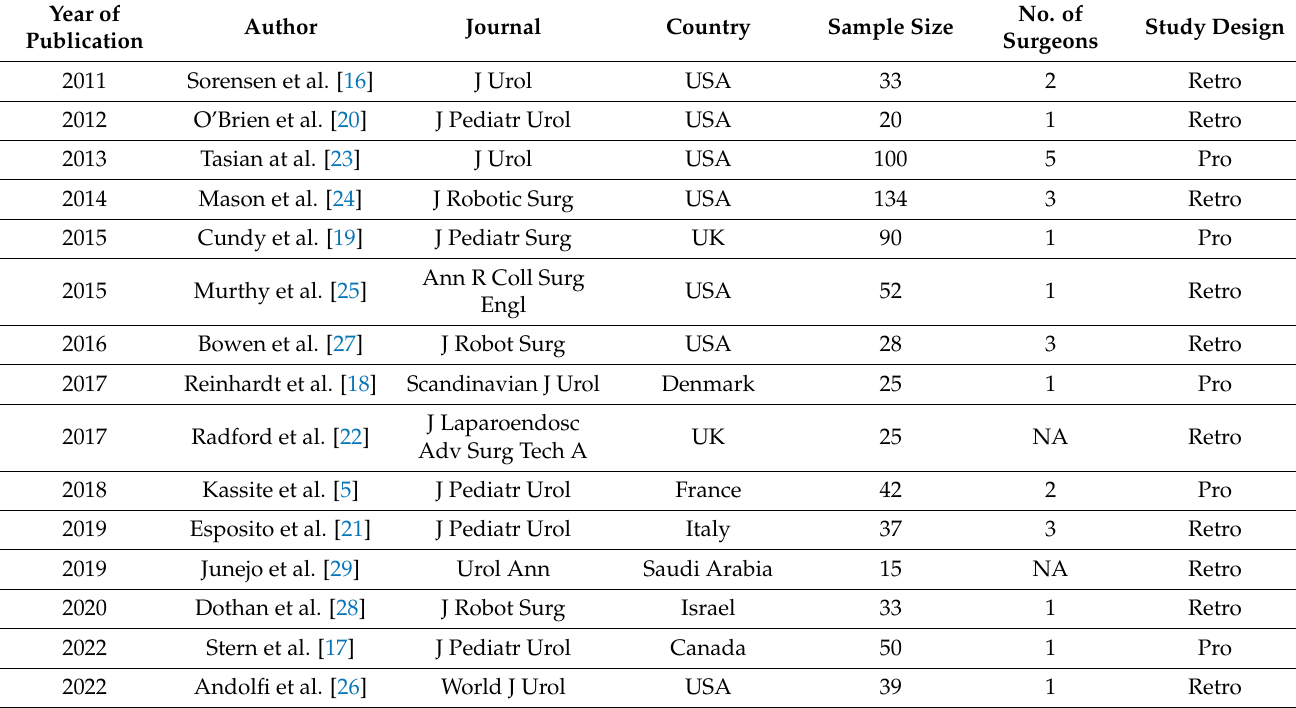
Table 1. Baseline characteristics of the included